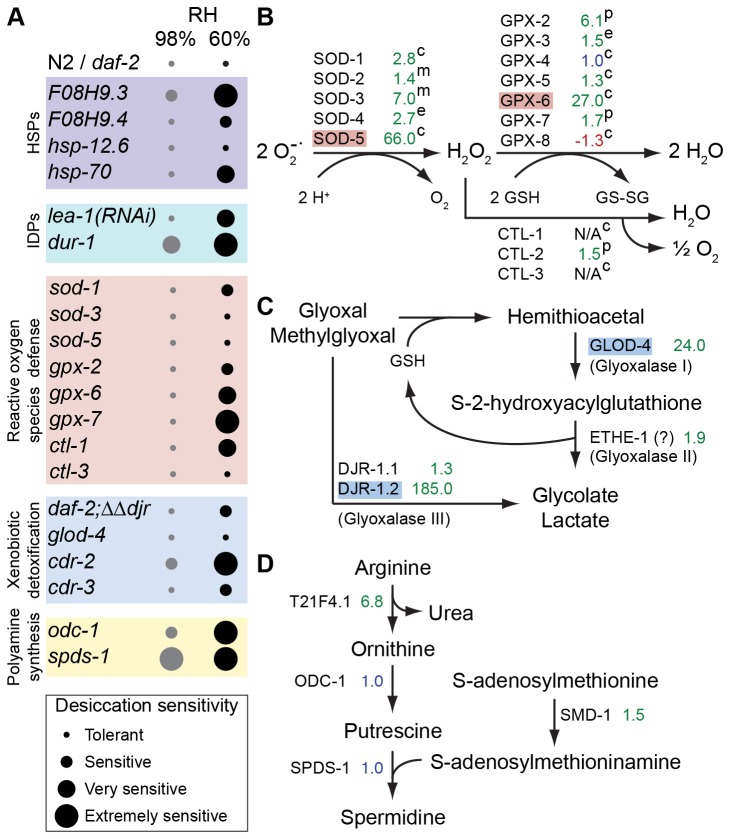
Major pathways involved in desiccation tolerance.(A) Desiccation sensitivities of various mutants from (B-D) candidate pathways are presented in 4 categories. Genes from high FCC are highlighted according to Figure 1. The subcellular localizations of ROS defense enzymes are shown as c, cytosol; e, extracellular; m, mitochondrion; and p, peroxisome.